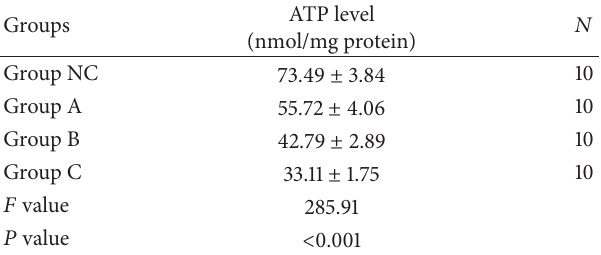
Table 4: Effects of simvastatin on ATP levels in MIN6